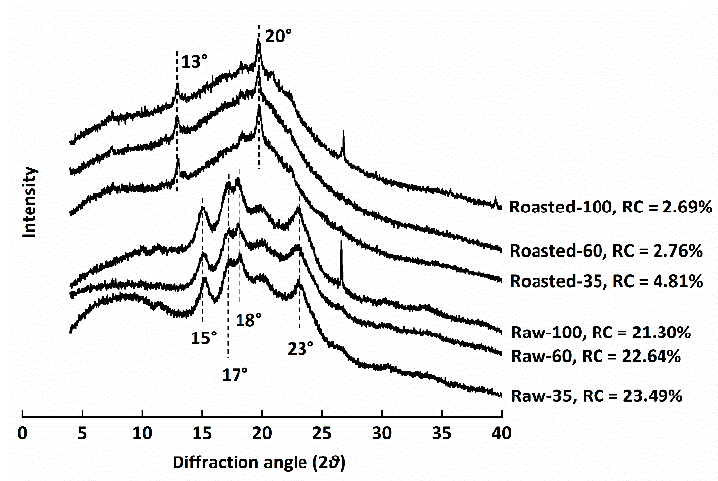
Figure 3. X-ray diffraction patterns of raw and sand-roasted highland barley flours. Raw-35, Raw-60, and Raw-100 indicate raw highland barley flour as coarse (250–500 µ m), medium (150–250 µ m), and fine (<150 µ m) fraction, respectively; while Roasted-35, Roasted-60, and Roasted-100 indicate sand-roasted highland barley flour as coarse (250–500 µ m), medium (150–250 µ m), and fine (<150 µ m) fraction, respectively. RC: relative crystallinity.